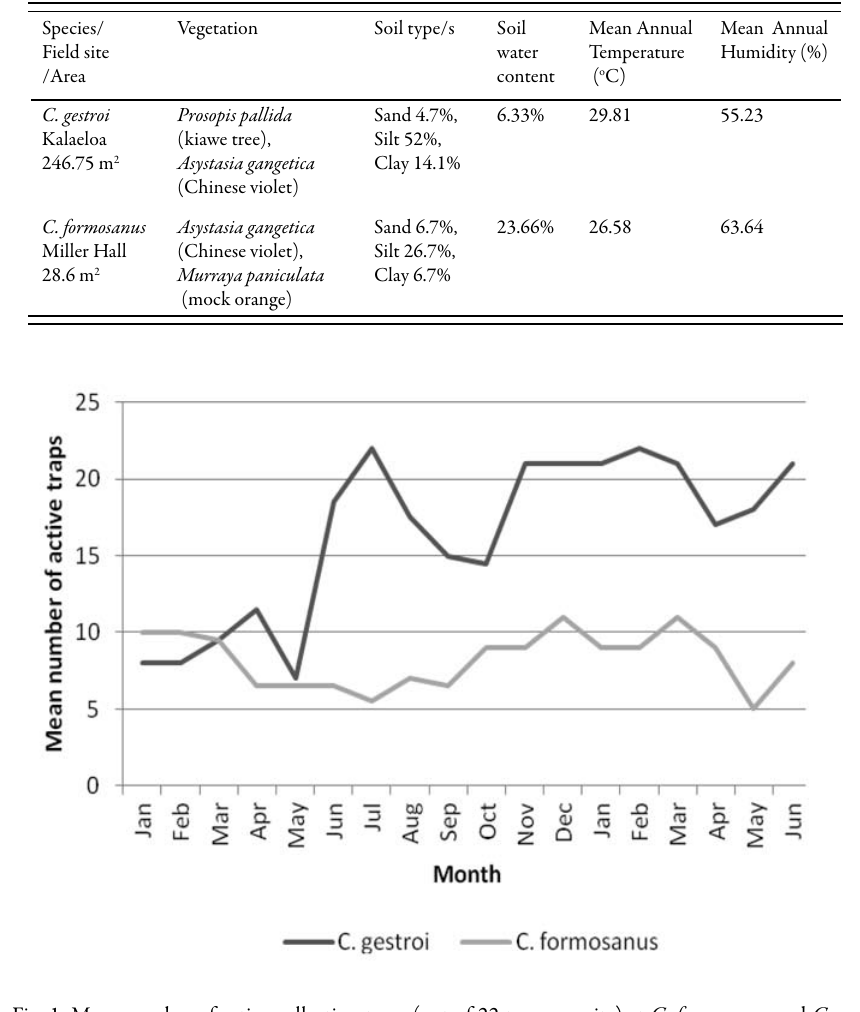
Fig. 1. Mean number of active collection traps (out of 22 traps per site) at C. formosanus and C. gestroi field sites on Oahu, Hawaii, plotted against month from January 2010